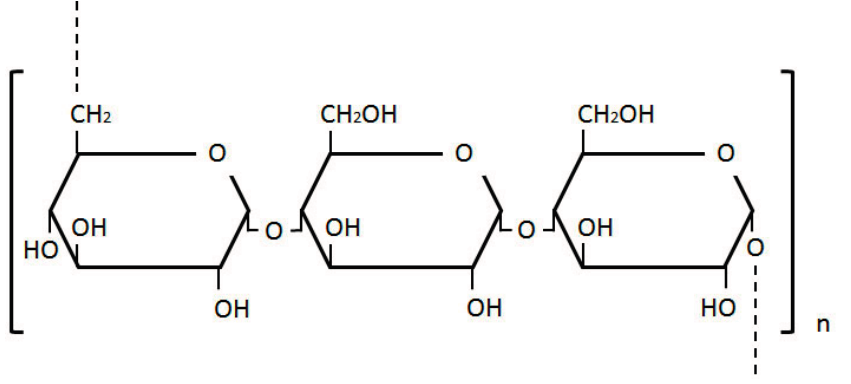
Figure 9. Pullulan structure, composed of maltotriose